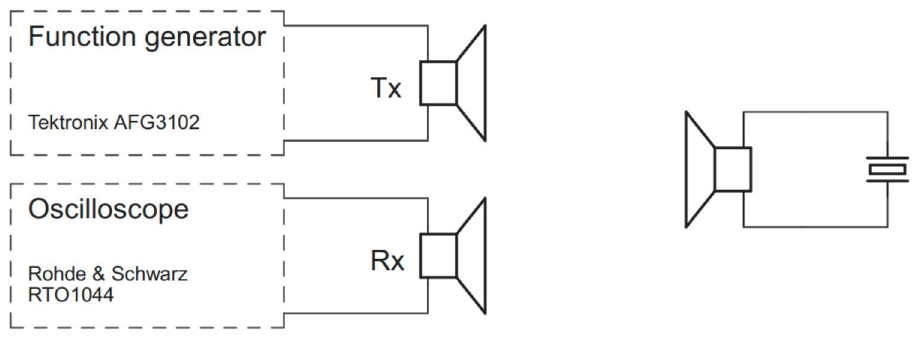
Figure 2. Measurement setup with laboratory equipment for the proof of concept with a quartz tuning fork